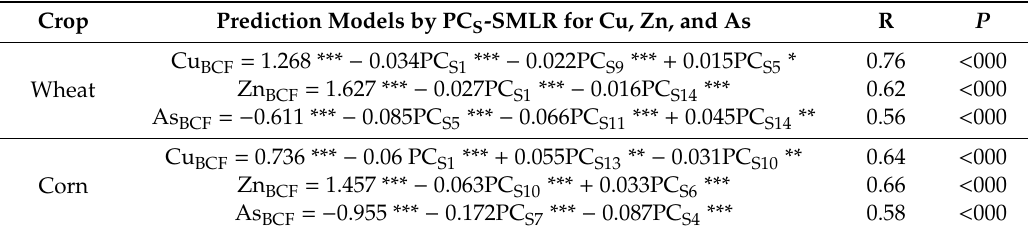
Table 3. The prediction and analysis results of BCF of Cu, Zn, and As in wheat and corn, plus soil properties by PC S